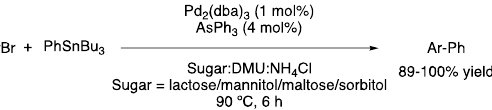
Table 2. Selected examples of cyclization processes catalyzed by transition metals in DESs.